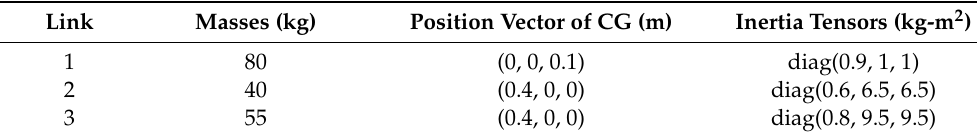
Table 1. Inertial properties of links.